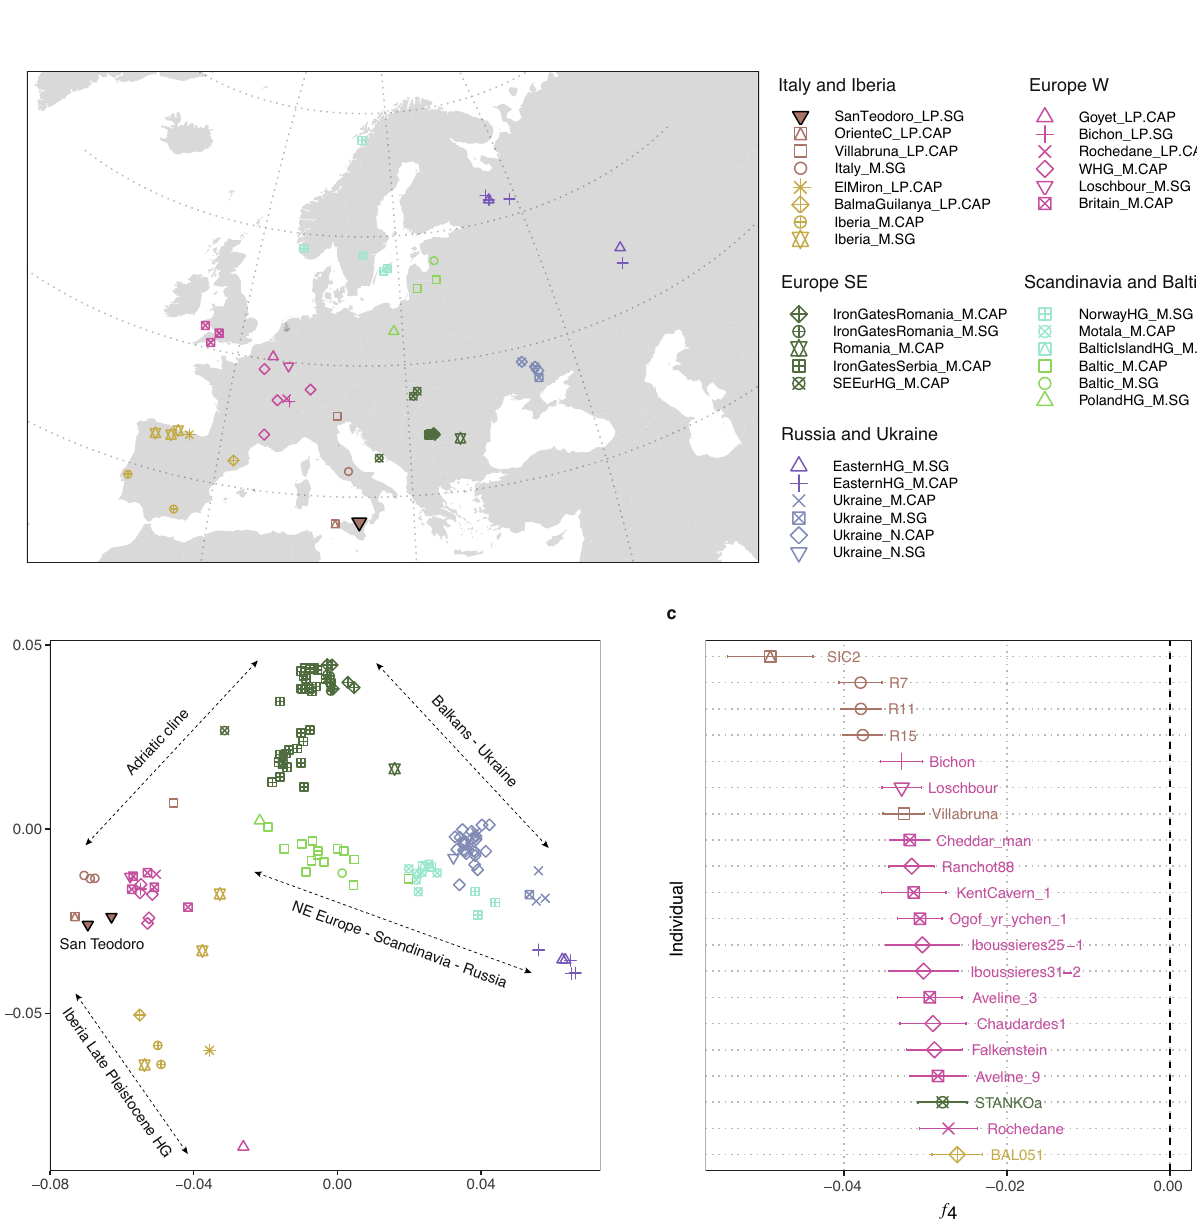
Fig. 1 Genetic clustering of European post-LGM hunter-gatherers. a Geographic location of new individuals from San Teodoro and previously published post-LGM hunter-gatherer individuals; b Multidimensional scaling (MDS) of 138 hunter-gatherer individuals (>50,000 SNPs covered) based on a pairwise identity-by-state (IBS) allele sharing. Major ancestry clines are indicated with dotted arrows. c Genetic af fi nities with the San Teodoro individuals. Shown are point estimates and standard errors for statistic f 4 (Mbuti, Test; SanTeodoro_LP.SG, DevilsCave_N.SG), which measures allele sharing of a test individual with San Teodoro compared to Neolithic hunter-gatherers from East Asia. More negative statistics indicate higher genetic af fi nity with San Teodoro. The top 20 individuals with the highest af fi nity are shown (Supplementary Data